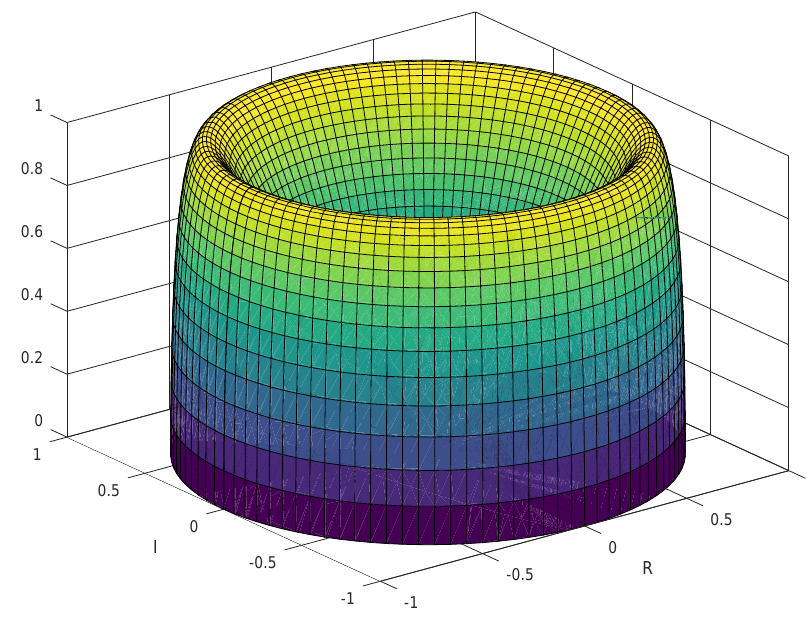
Figure 1. Contour plot of the type-A entropy calculated from Equation (4).